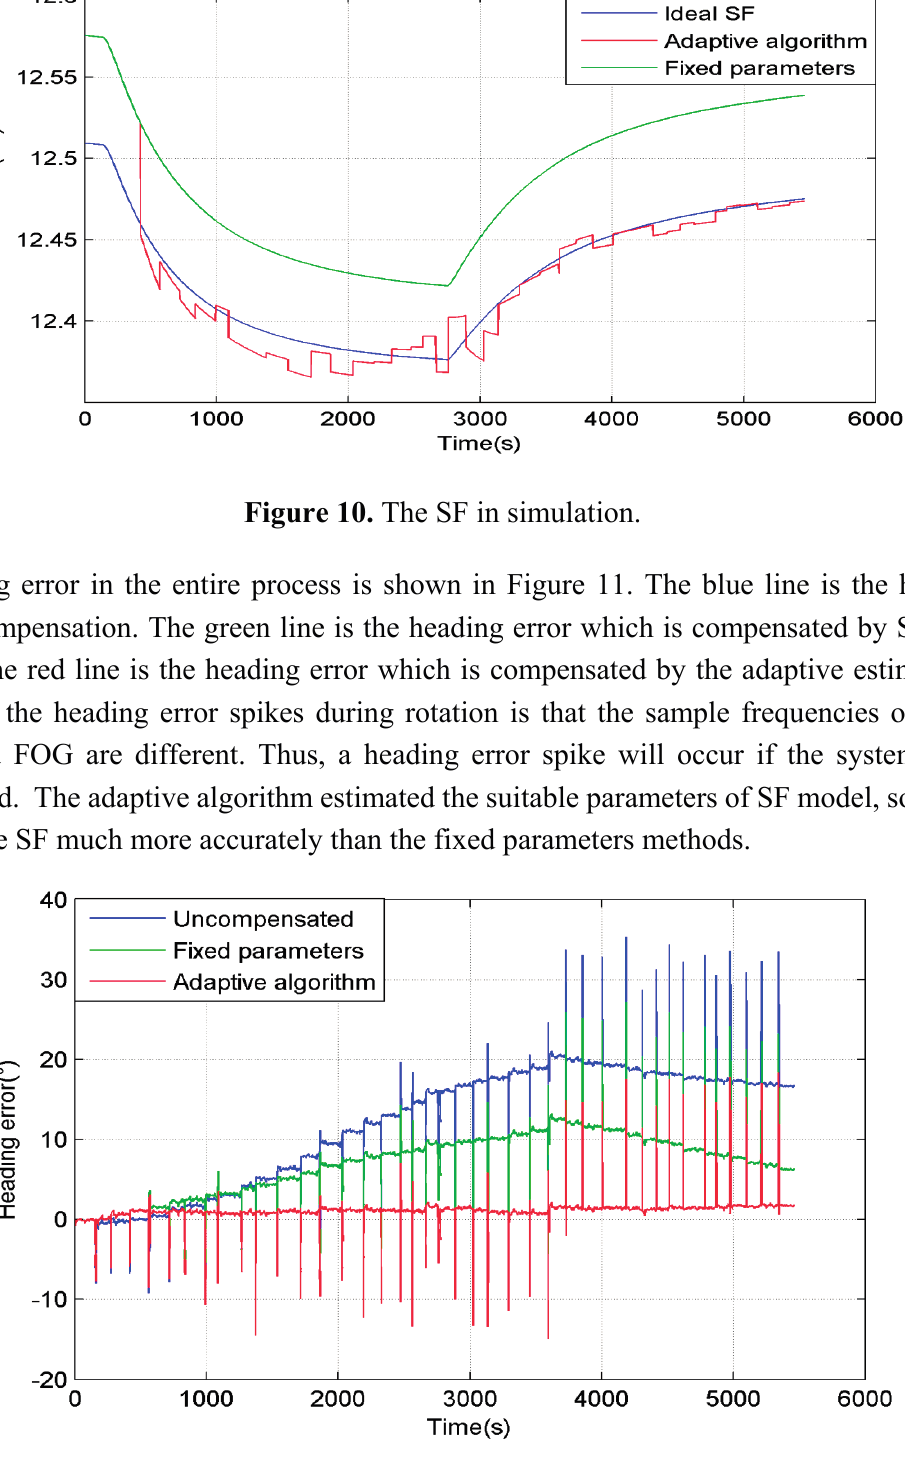
Figure 11. The heading error in simulation of